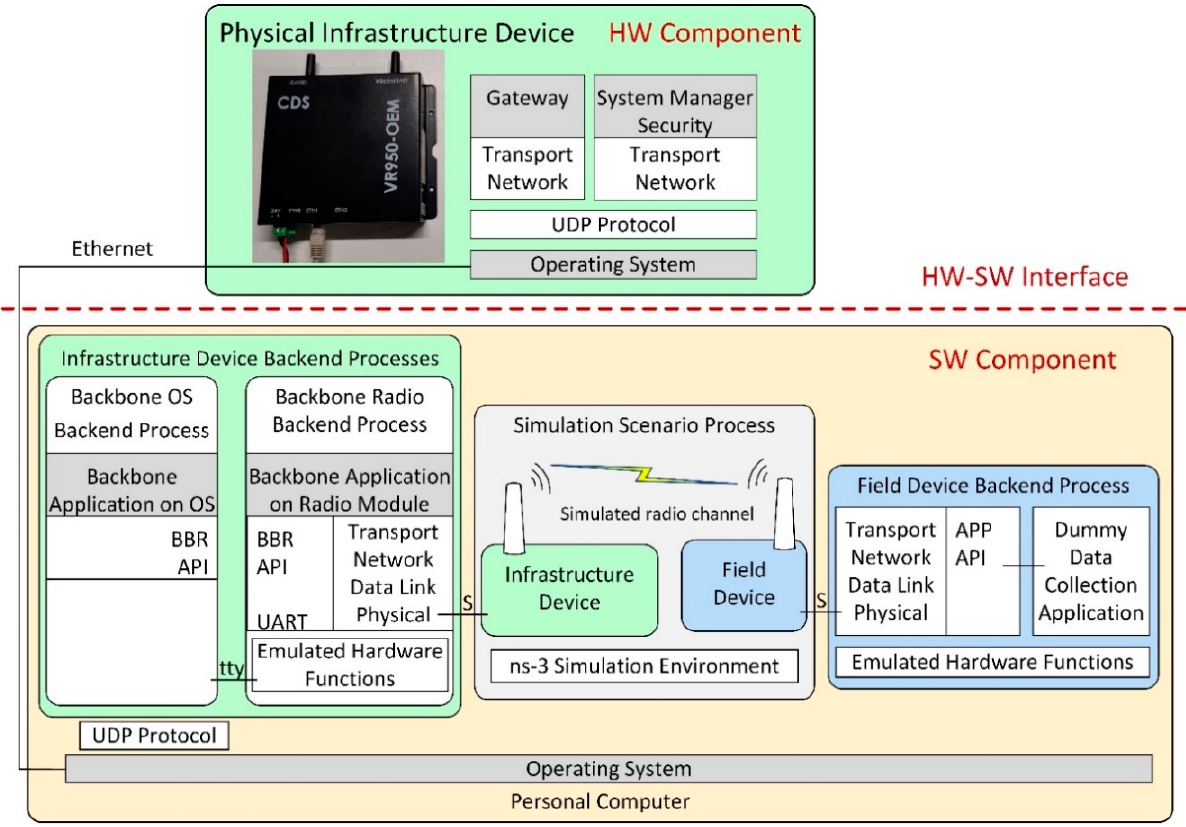
Figure 6. Gateway-in-the-loop scenario architecture.